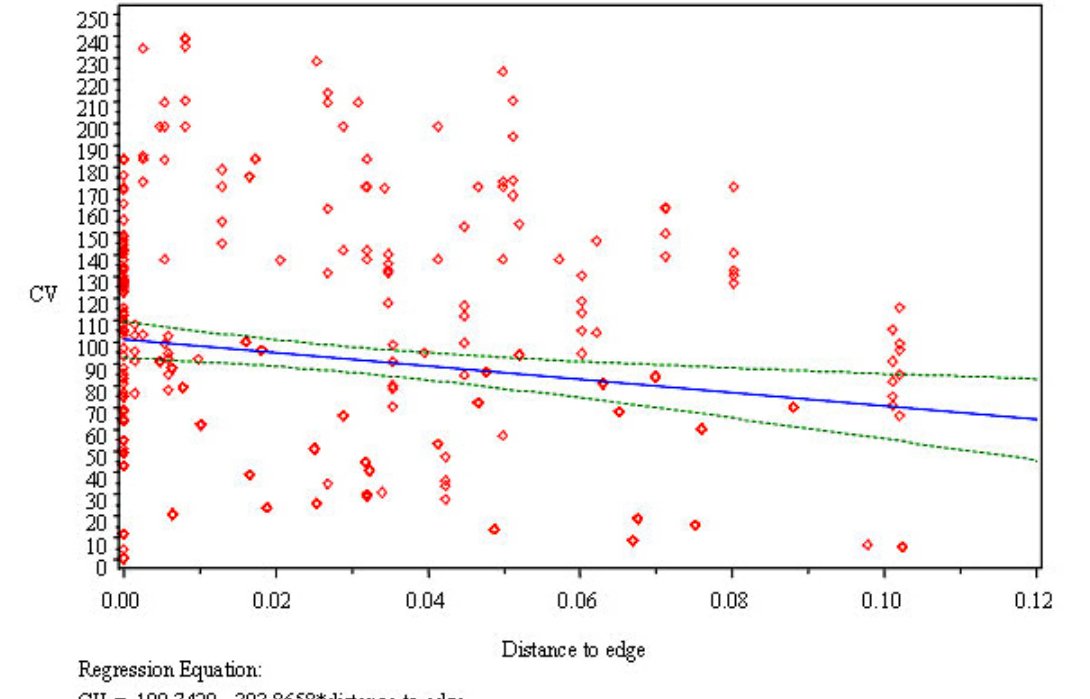
Fig. 6. Plot of coefficient of variation (CV) in relation to distance-to-edge (edge) of truncated data for spatial analysis of bird species of the Florida Everglades sub-ecoregion. Each point (diamond) represents one species during 1 year and their respective CV and edge. The regression line (solid line) is accompanied by its 95% confidence limits (dashed